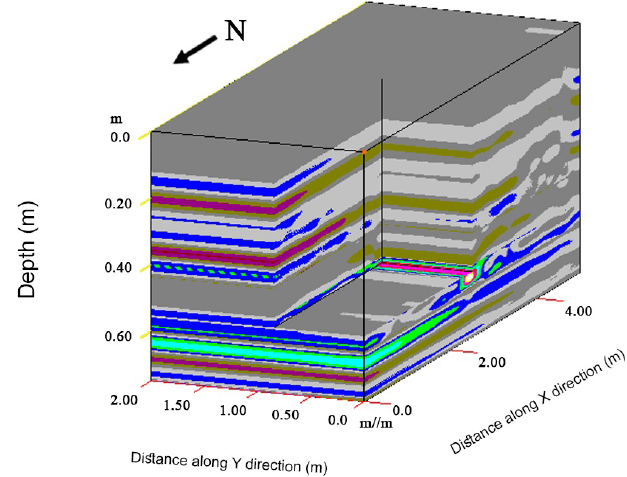
Figure 12. The 3D section (cutout cube) using x = 2 . 5, y = 0 . 85, and z = 0 . 55m shows clearly the depth and extension of the pipe perpendicular to the x position and the depth of the top of pipe de- tect by the z position.